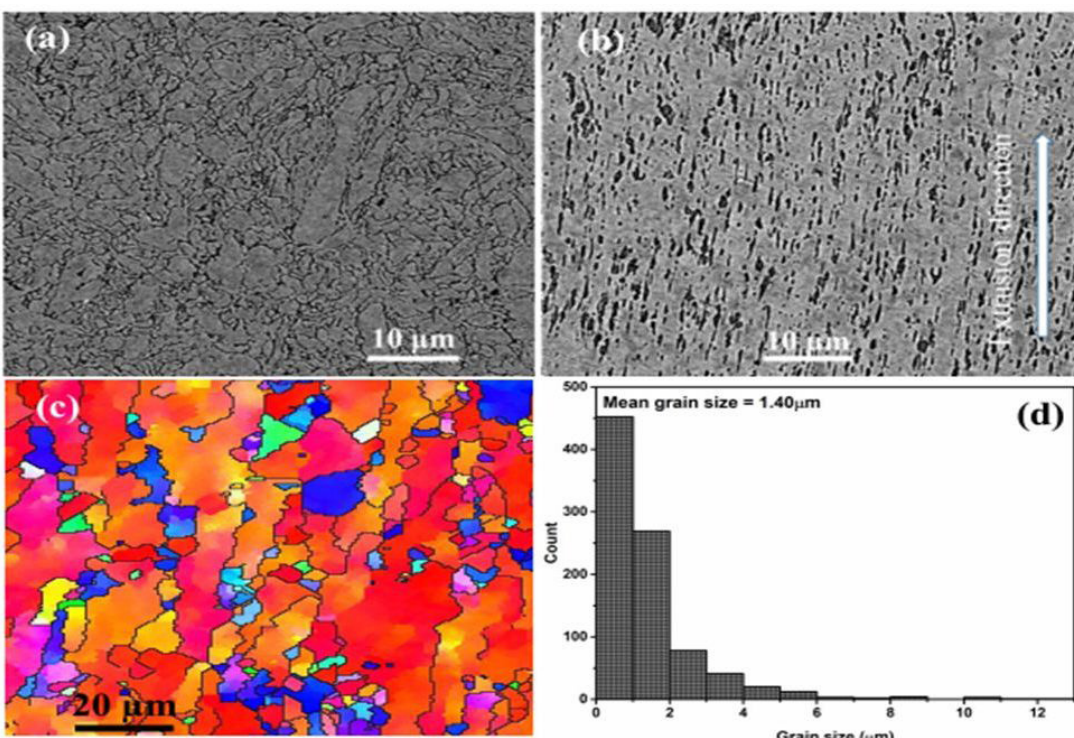
Figure 4. (a) and (b) BEI images of the as-SPSed and as-extruded samples, (c) EBSD inverse pole figure (IPF) contrast map and (d) the grain size distribution of as-extruded